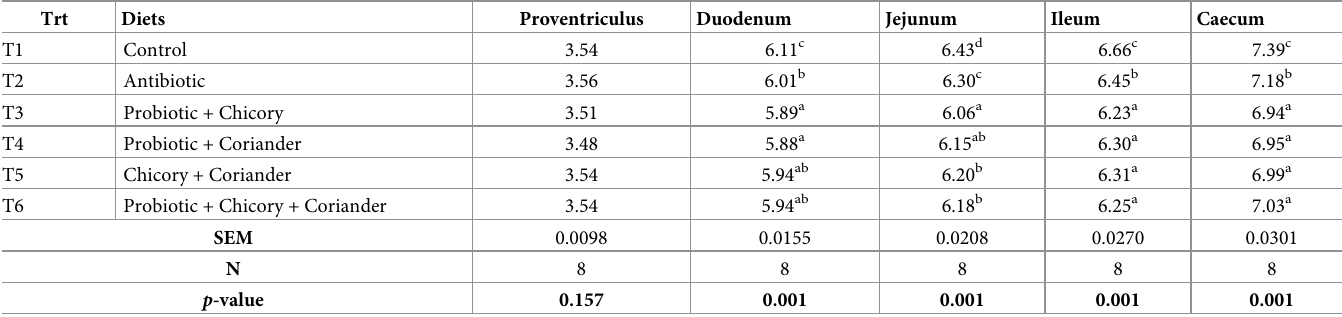
Value bearing different superscripts within a column are significantly (P < 0.05) different